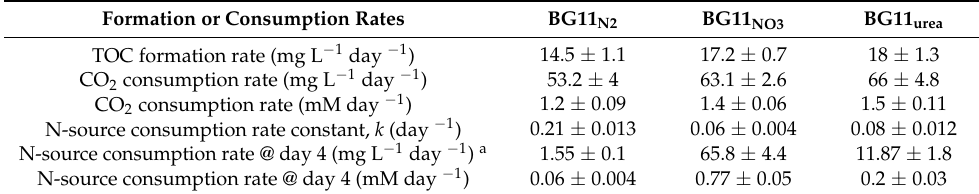
Table 2. Rate constants for C- and N-source consumption. Total organic carbon (TOC) formation rates represent the zero-order rate constant. N-source consumption is shown in Figure S9. Equivalent CO 2 consumption rate was calculated by multiplying TOC formation rate by 3.67. Numbers represent averages and standard deviations for consumption/ fixation rates considering at four biological replicates per medium type and a total of 56 TOC